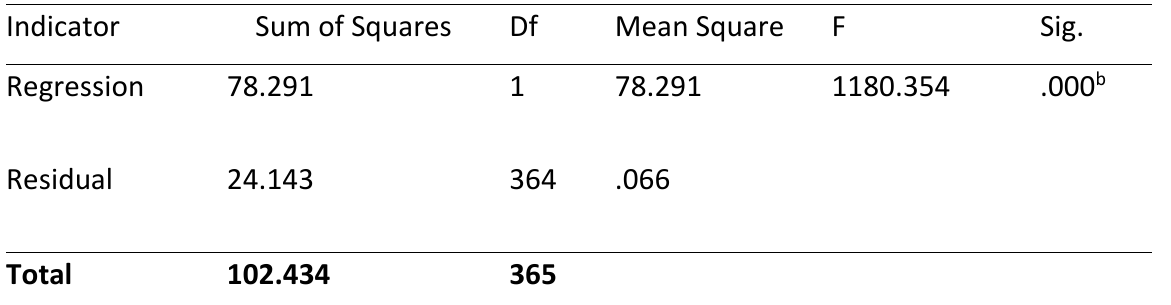
Table 7. Analysis of variance